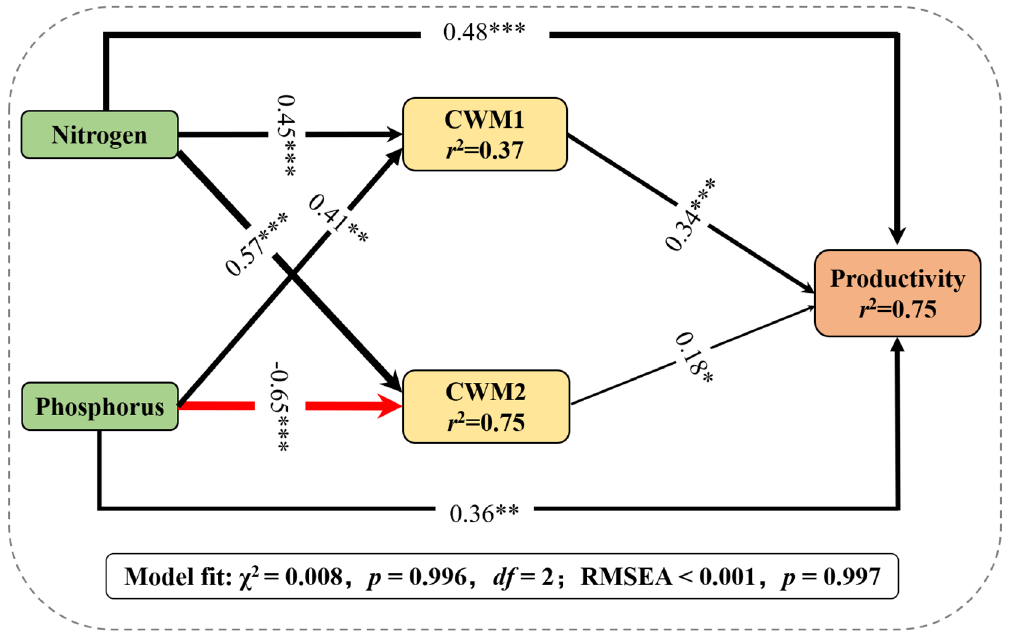
Figure 4. Results of the structural equation model. The arrows represent the hypothesized causal relationships between the variables. The solid lines represent significant relationships ( p < 0.05). Black arrows represent positive effects, and the red arrows represent negative effects. The values next to the arrows are the standardized path coefficients. The line thickness is proportional to the standardized path coefficient. * p < 0.05; ** p < 0.01; *** p < 0.001. CWM1 and CWM2: the first two PCA axes of CWM traits. CWM